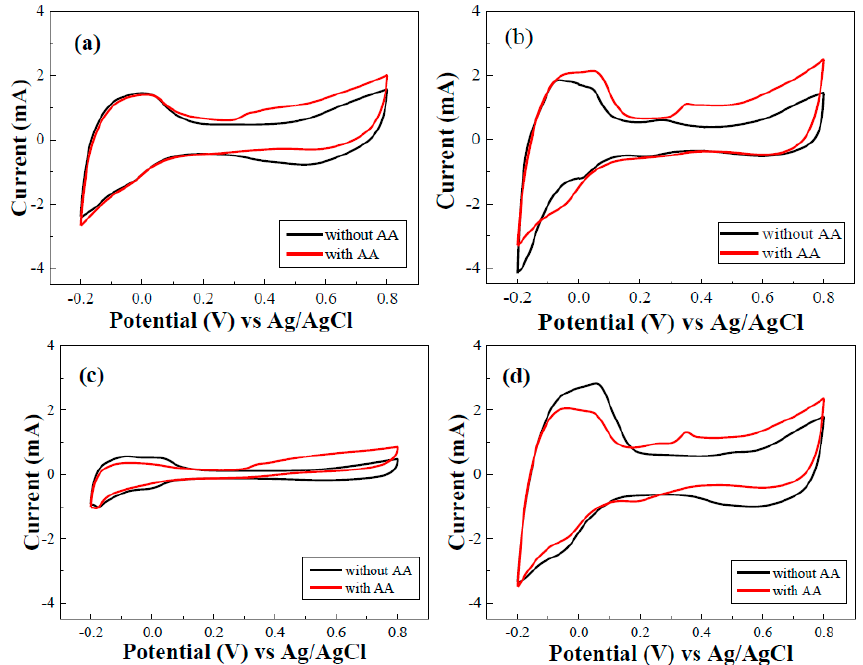
Figure 3. Cyclic voltammograms in the presence and absence of 25 mM AA for ( a ) Pt/C; ( b ) Pt-Mo/C; ( c ) Pt-Zr/C; and ( d ) Pt-Fe-Ir/C electrocatalysts: scan rate = 0.1 V/s, in 0.5 M HClO 4